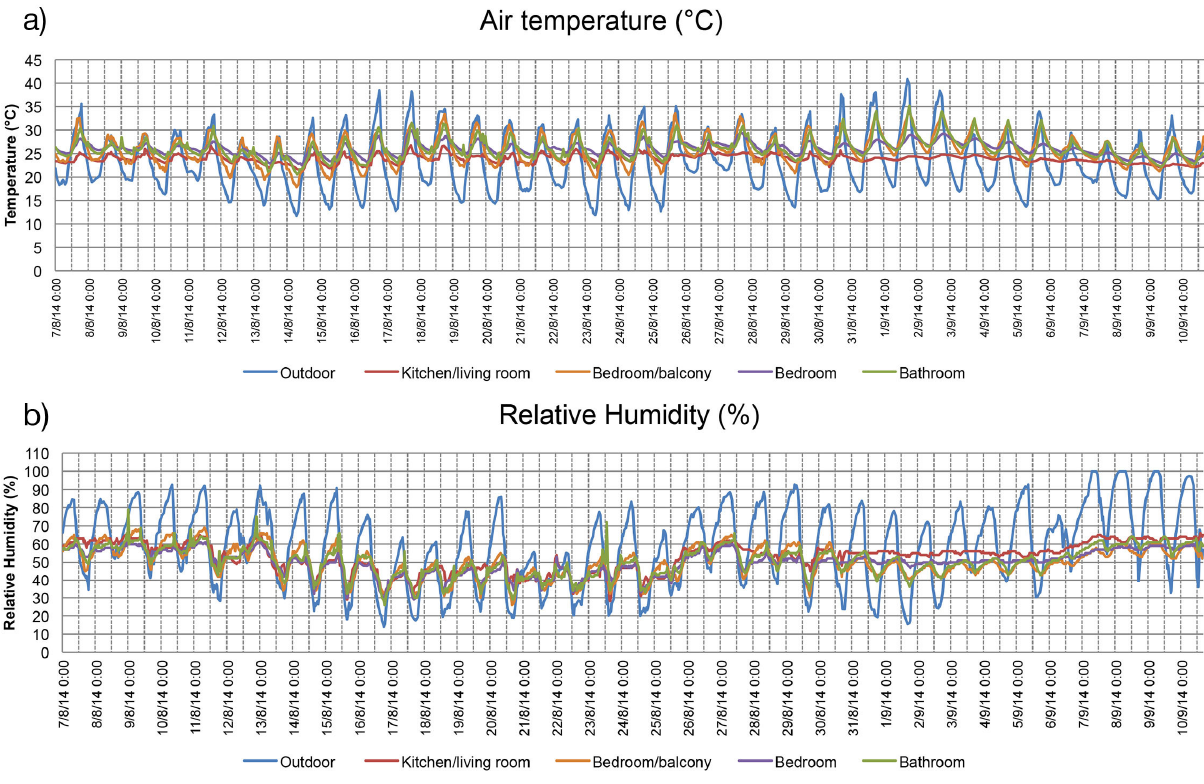
Figure 8. Case study 1 performance during summer season. ( a ) Indoor and outdoor air temperature profile; ( b ) Indoor and outdoor relative humidity